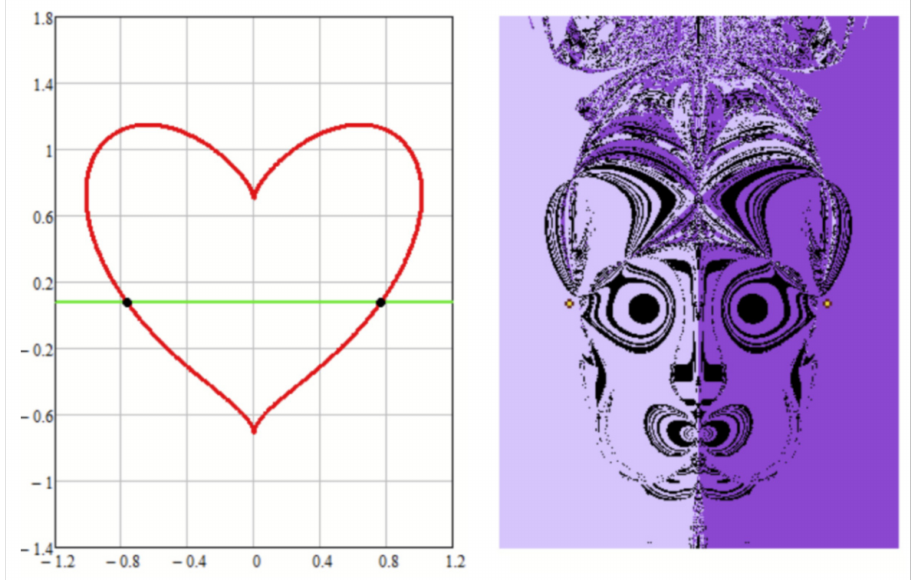
Figure 17. “Portrait” of the roots of the system of Equation (3), obtained by the Levenberg–Marquardt method, for the case y = 0.082.